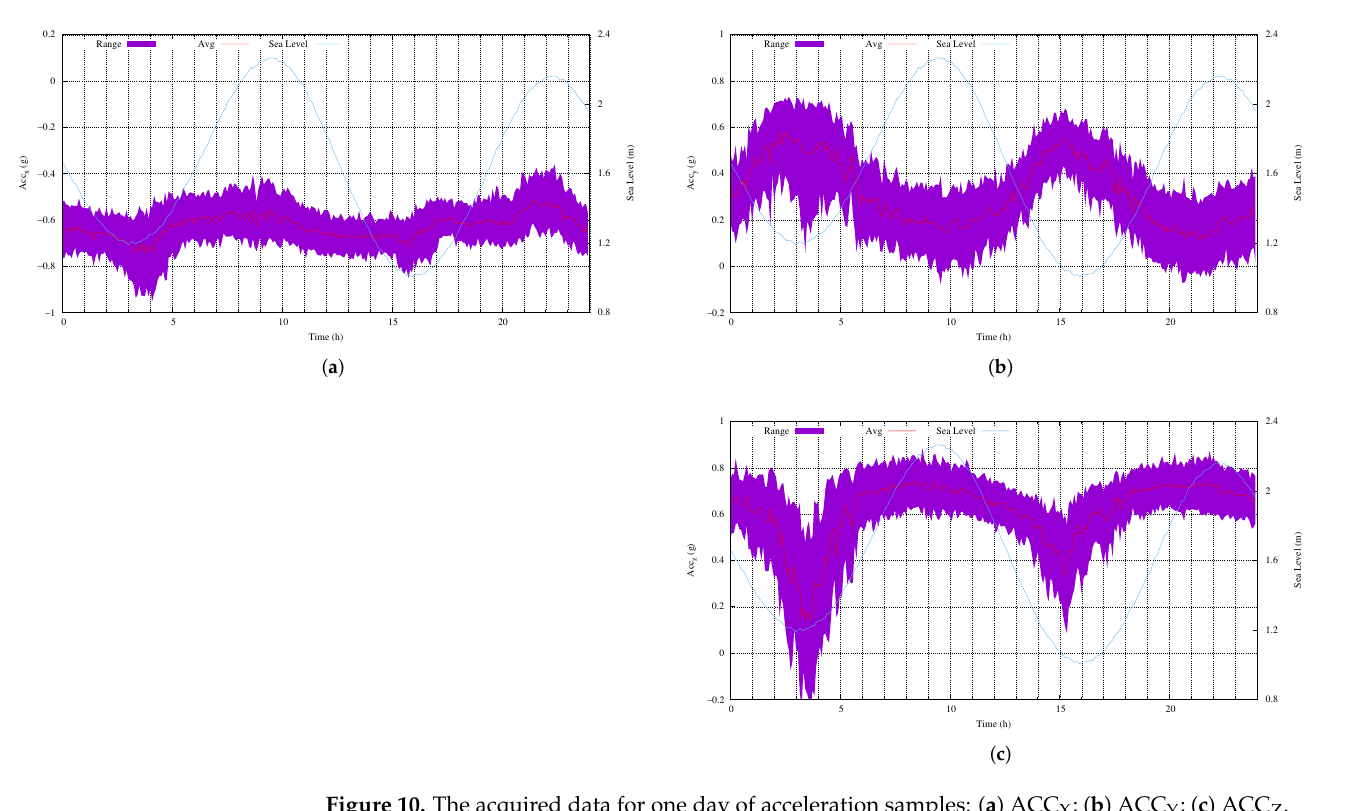
Figure 10. The acquired data for one day of acceleration samples: ( a ) ACC X ; ( b ) ACC Y ; ( c ) ACC Z . Figure 10a–c represent the range of measured acceleration values and the average acceleration values for ACC X , ACC Y and ACC Z , respectively (they are referred to by their left ordinate). In addition, the sea level that was measured by the Faro tide gauge is also presented in meters (right